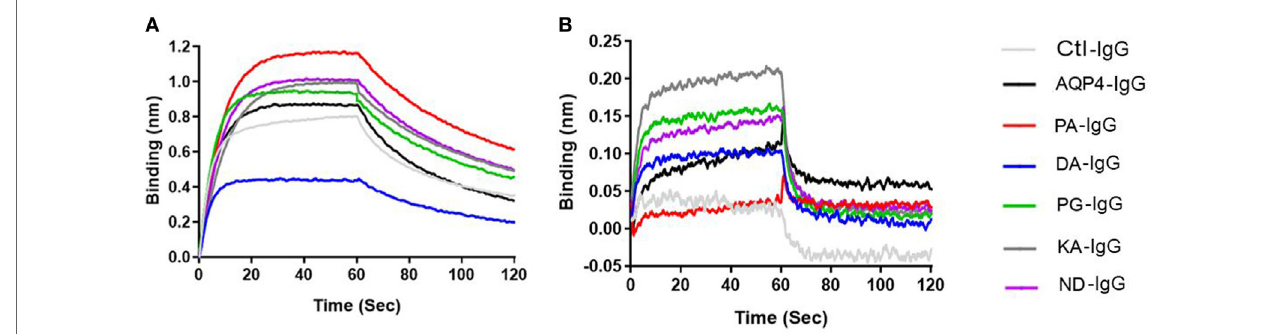
FigUre 5 | Antibodies binding to mouse FcRn. ForteBio kinetic. Ctl-IgG and AQP4–IgG and Fc-mutated antibodies (6 µg/ml) were loaded to the sensors. The sensors were exposed to 2 nM FcRn solution for association (0–60 s) and for dissociation solution (60–120 s). Sensorgrams showing the association and dissociation steps. (a) pH 6 and (B) pH 7.2. See Table 2 for Rmax and Req of all antibodies. Each antibody was analyzed three independent times and representatives are